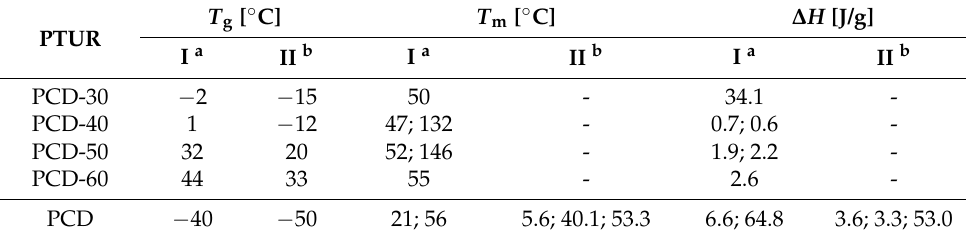
Table 4. DSC data of the synthesized PTURs and